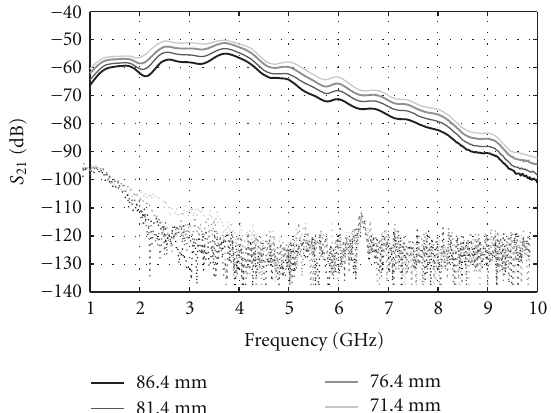
Figure 12: Transmission magnitude for the 35-year-old volunteer, left breast with di ff erent separation distances between the sensors. The dashed curves correspond to the transmission measured for the same distances but without the breast present.